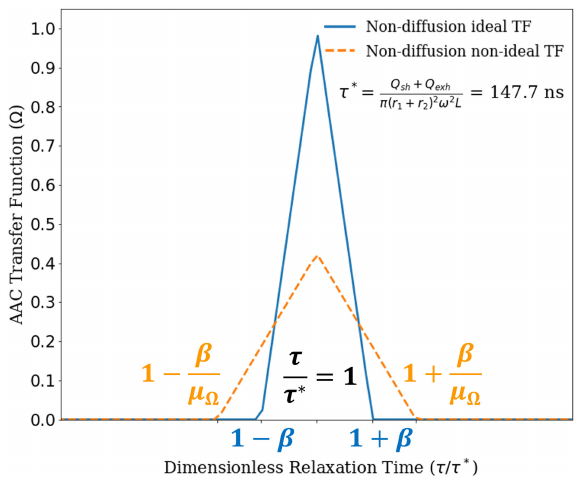
Figure 3. The ideal (blue) and nonideal (NI) (orange) AAC trans- fer functions based on the particle streamline non-diffusion (ND) model as developed by Tavakoli and Olfert (2013). The transfer functions are shown relative to 150nm aerodynamic diameter as the set point. This corresponds to a relaxation time set point of 147.7ns. It can be observed that the NI transfer function maximum is signif- icantly reduced compared to the ideal transfer function, which is attributed to a reduced transmission efficiency for the NI transfer function. Additionally, the transfer function broadening is higher for the NI transfer function, which is quantified using the transfer function width factor. Overall, the NI transfer function provides an improved basis for particle size selection using the